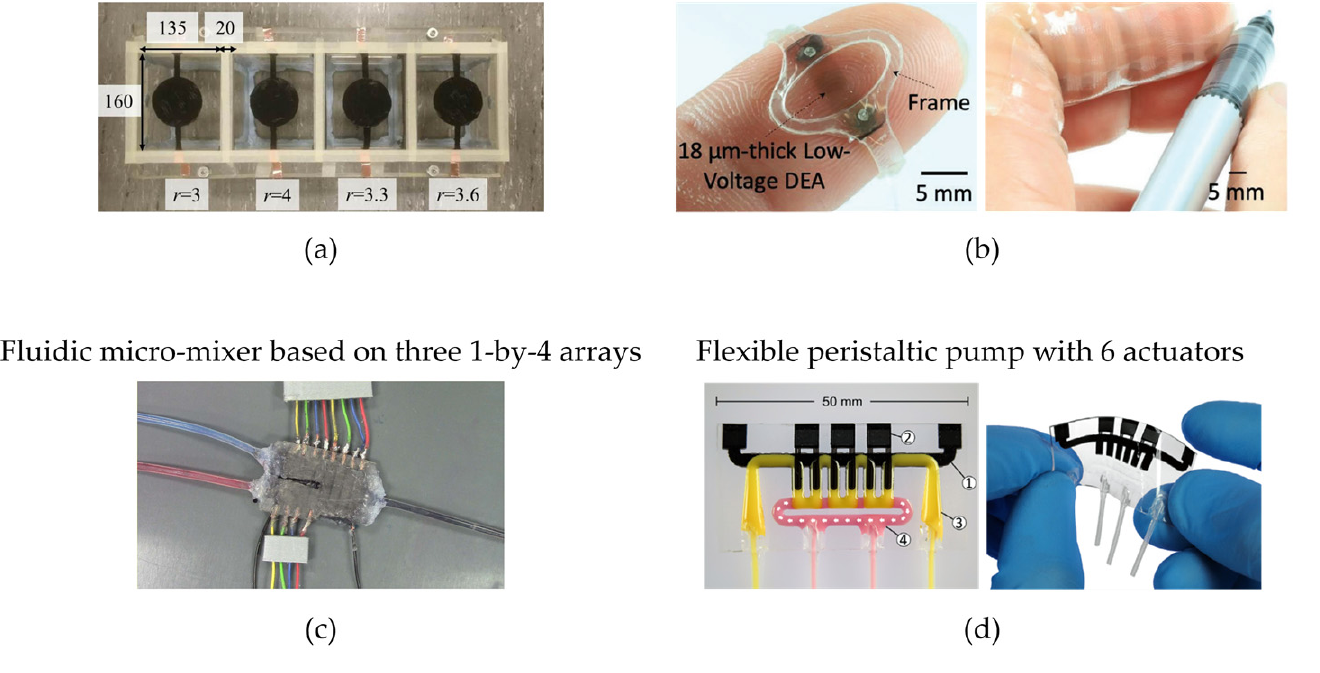
Figure 8. Examples 1D DE arrays: ( a ) 1-by-4 tunable resonator [128]; ( b ) 1-by-10 untethered fee-through haptic actuator [129], reproduced with permission from John Wiley and Sons, copyright 2020; ( c ) Fluidic micro-mixer based on three 1-by-4 arrays [130], reproduced with permission from IOP Publishing Ltd., copyright 2018; ( d ) Flexible peristaltic pump with 6 integrated actuators [131].